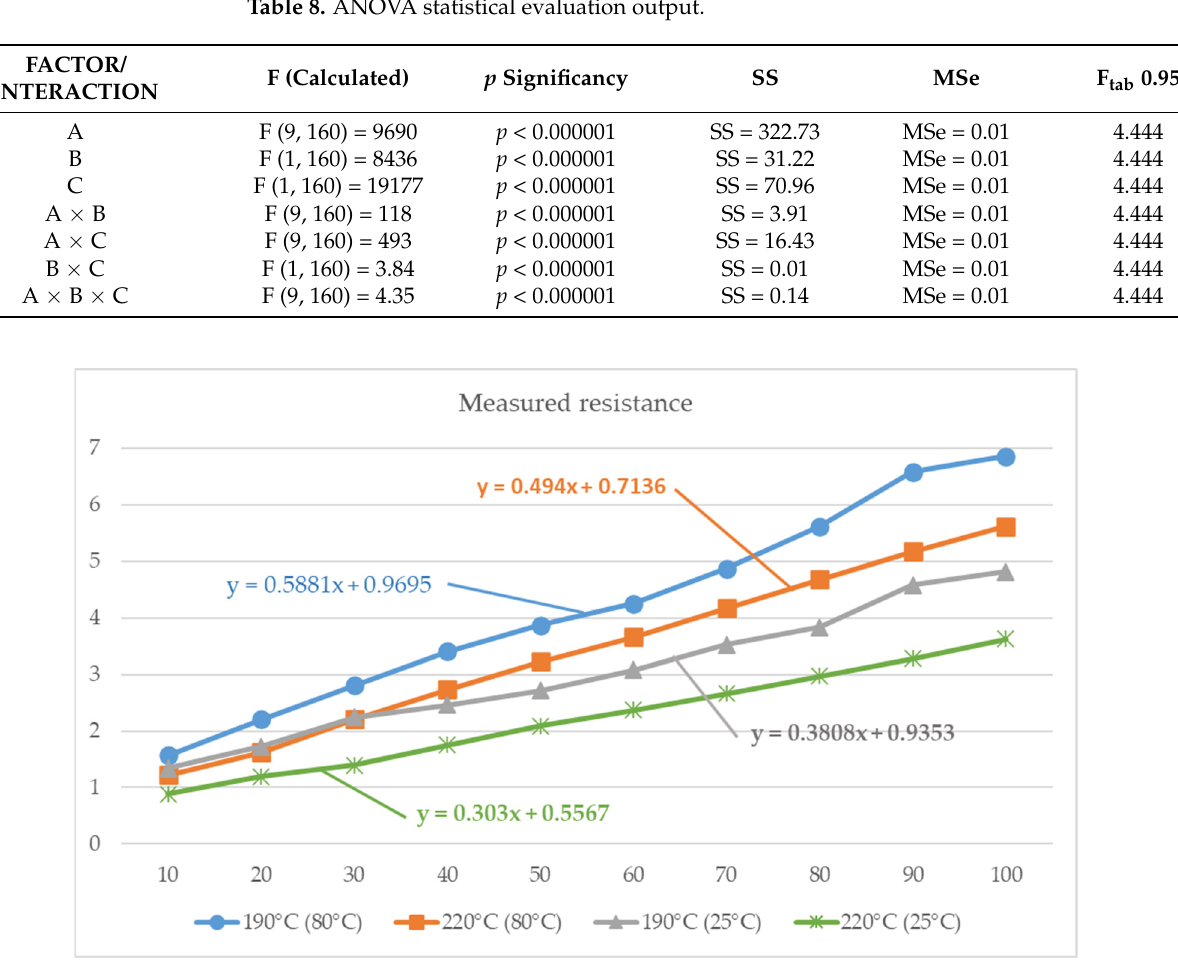
Figure 9. Dependance of resistance on sample length for measurement at 25 °C and 80 °C.